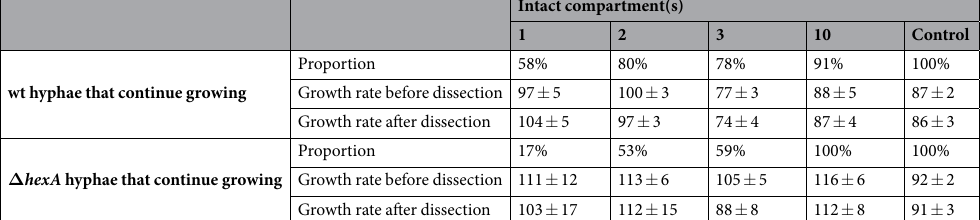
Table 1. Proportion of wild-type and Δ hexA hyphae that continue growing after laser dissection and their mean growth rate ( ± confidence interval) before and after laser dissection.